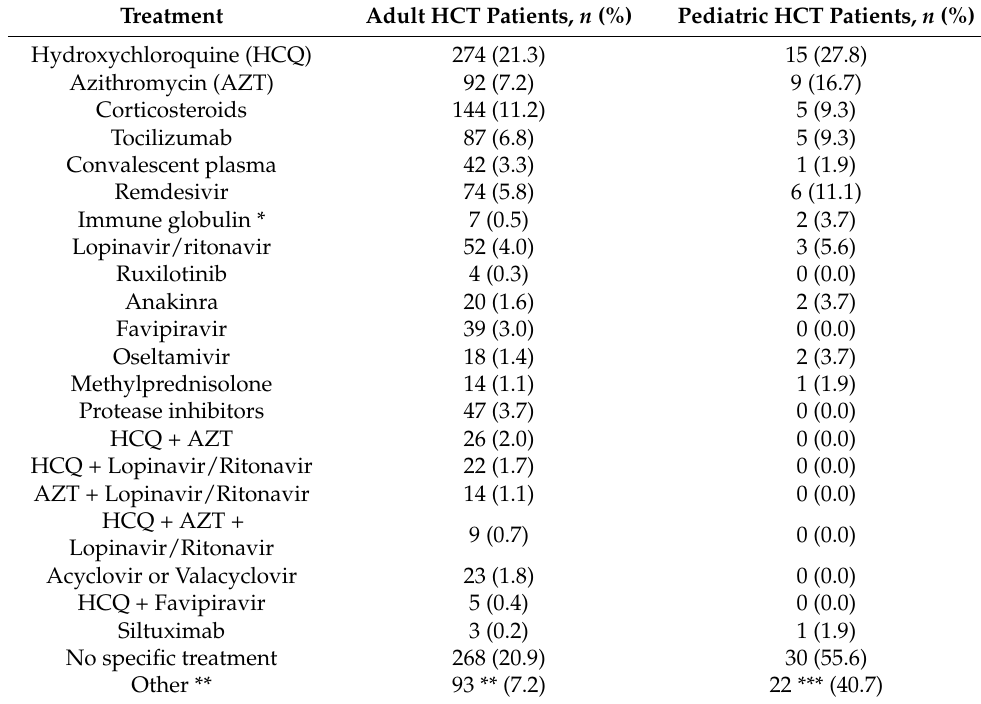
Table 3. Treatment of COVID-19 in patients following HCT. Note that, in almost all cases, patients received multiple treatments. Therefore, the totals exceed